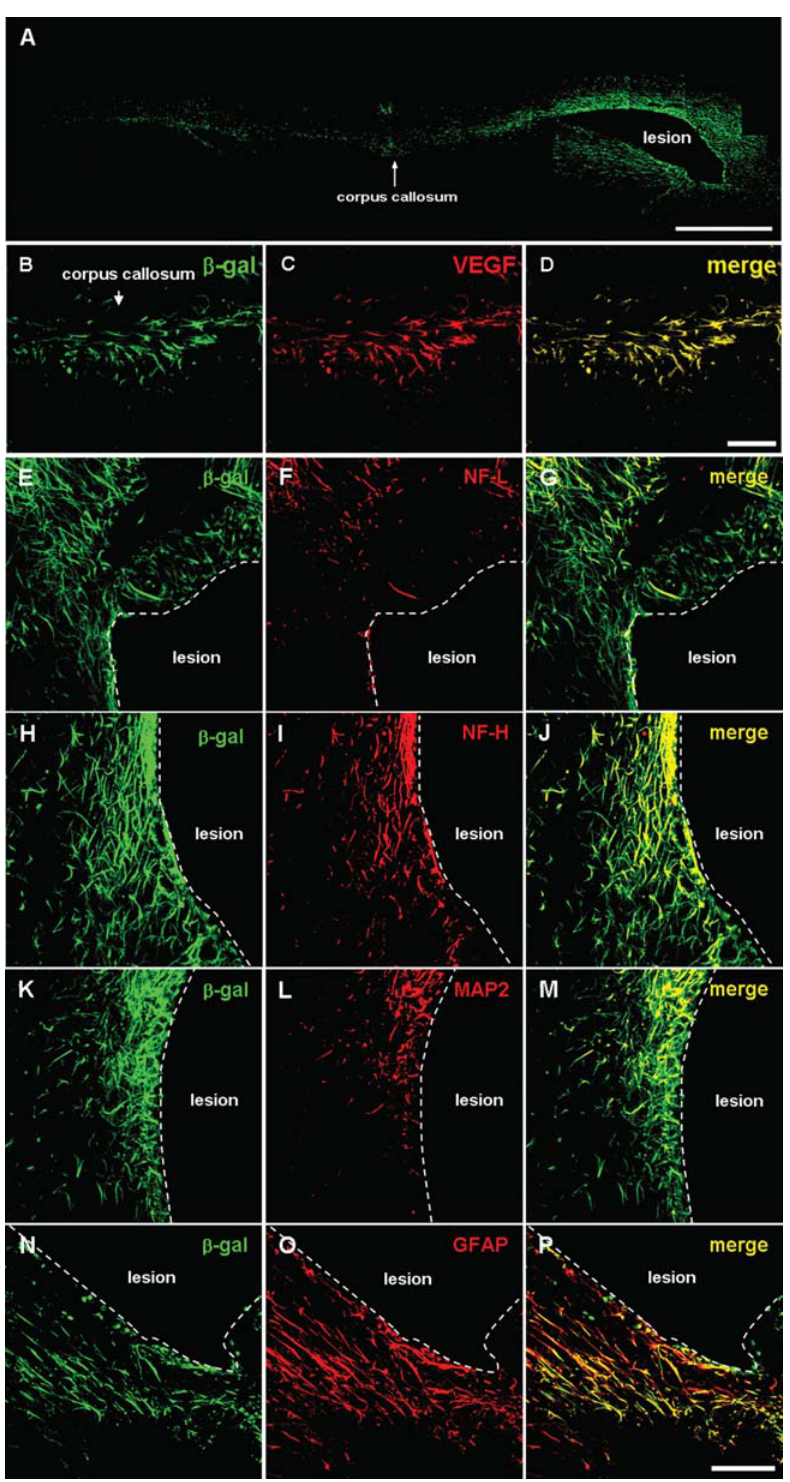
Figure 6. Good survival of F3.VEGF human neural stem cells pre-labeled with adeno-LacZ ( b -gal) was found in hemorrhage core or lesion border of experimental ICH mouse brain 8 weeks post-transplantation. A large number of LacZ + F3.VEGF human neural stem cells were found to migrate to contralateral side of hemisphere via corpus callosum (A). Higher magnification of migrating F3.VEGF cells is also shown (B–D). LacZ + F3.VEGF cells differentiate into neurons as shown by b -gal + /NF-L + (E–G), b -gal + NF-H + (H–J) and b -gal/MAP2 (K–M) and also into astrocytes as demonstrated by b - gal + /GFAP + staining (N–P). Bar indicates 50 m m.